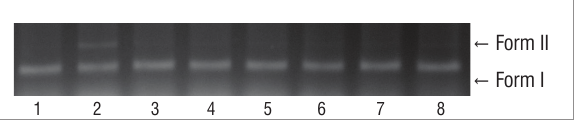
Figure 1 : Effects of pulsed electromagnetic fields (PEMF north and south), sonic waves (SW), radiofrequency (ECT) and intense pulsed light (IPL) on the survival fraction and inactivation induced by stannous chloride (SnCl ) in E. coli AB1157. As 2 a negative control, bacterial cells were incubated with NaCl (0.9%, 60 min) and as a positive control, bacterial cells were incubated with SnCl (25 µ g/mL, 60 min); controls were not 2 exposed to the physical agents.